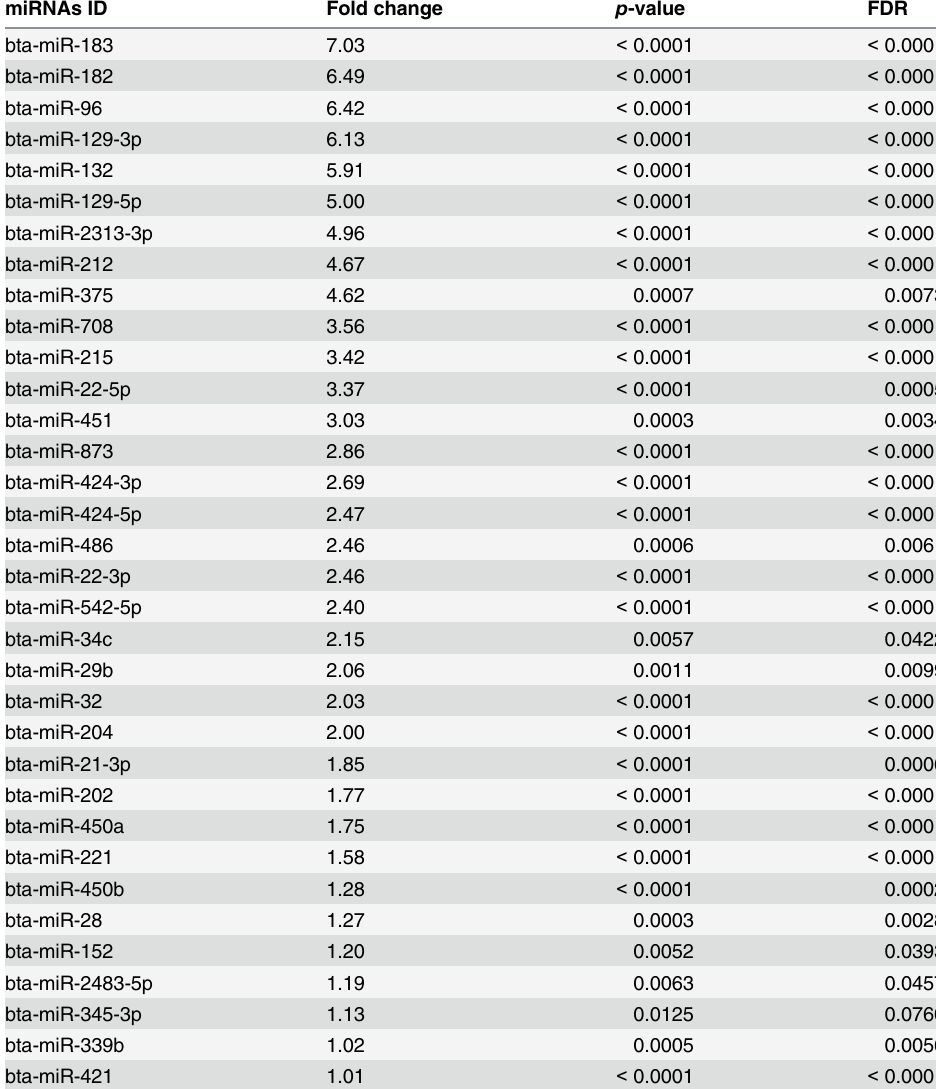
Table 4. List of miRNAs up-regulated in granulosa cells of preovulatory dominant follicles. miRNAs ID Fold